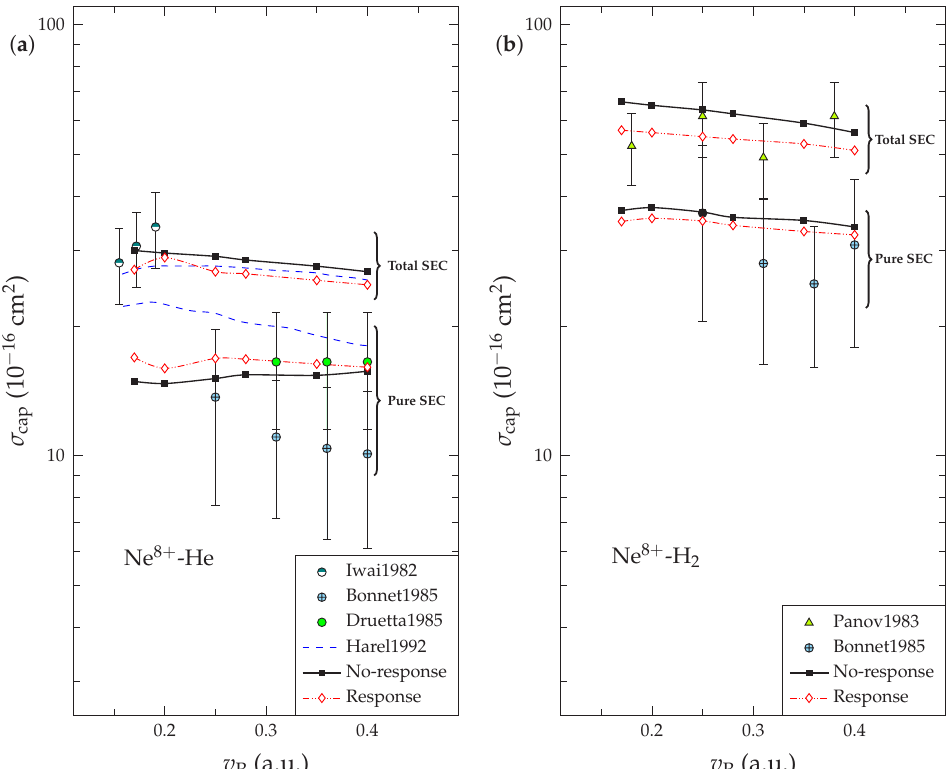
Figure 1. ( a ) Total capture cross sections with respect to the impact speed for Ne 8 + –He collisions. Pure single-electron capture (SEC) cross sections are separated from total SEC (pure SEC + autoionizing double-capture (ADC)). Experiments: Iwai et al. [48], Bonnet et al. [13], Druetta et al. [14]. Theory: Harel and Jouin [17], present work (no-response approximation and target-response model). ( b ) Same as ( a ) but for Ne 8 + –H 2 collisions. Experiments: Panov et al. [49], Bonnet et al. [13]. Theory: present